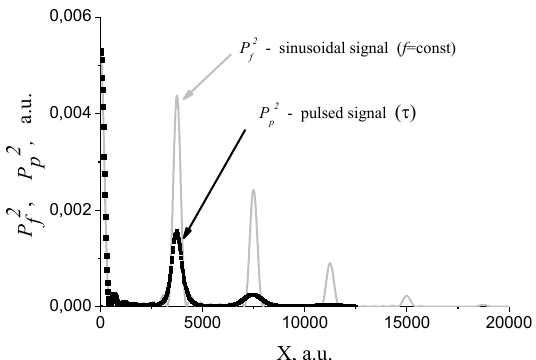
Fig. 4. Radiation patterns of CW (solid gray line) and short pulse (black dots) signals simulated for superposition of 8 Gaussian beams.